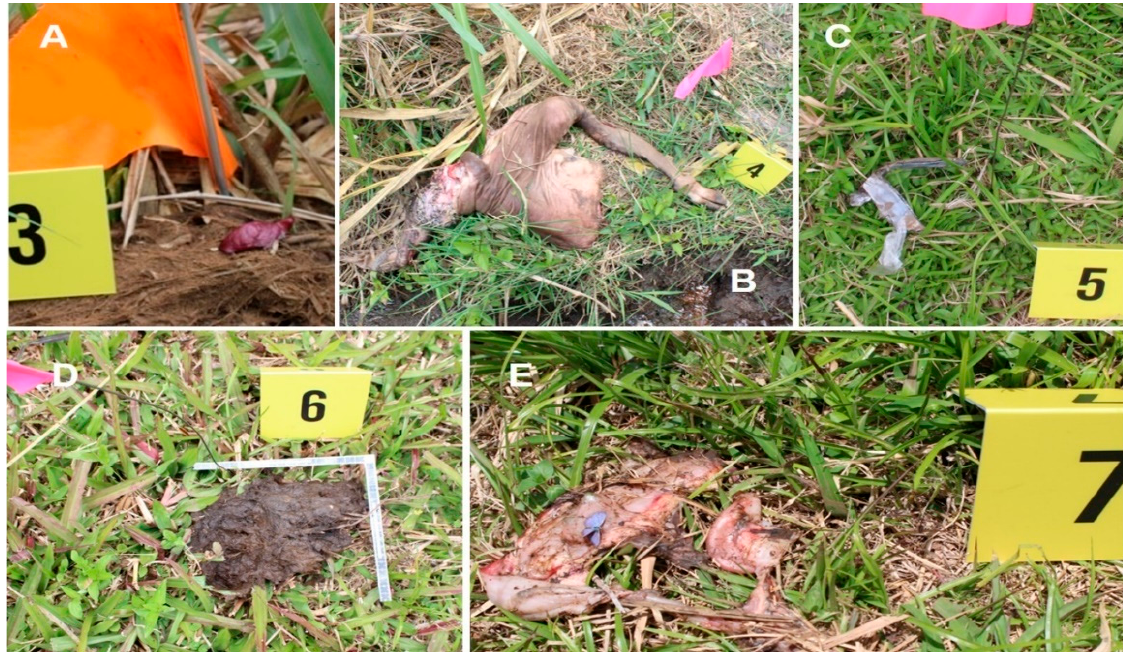
Figure 7. Evidences. ( A ) Fragment of spleen; ( B ) A large portion of the casing; ( C ) Container fragment